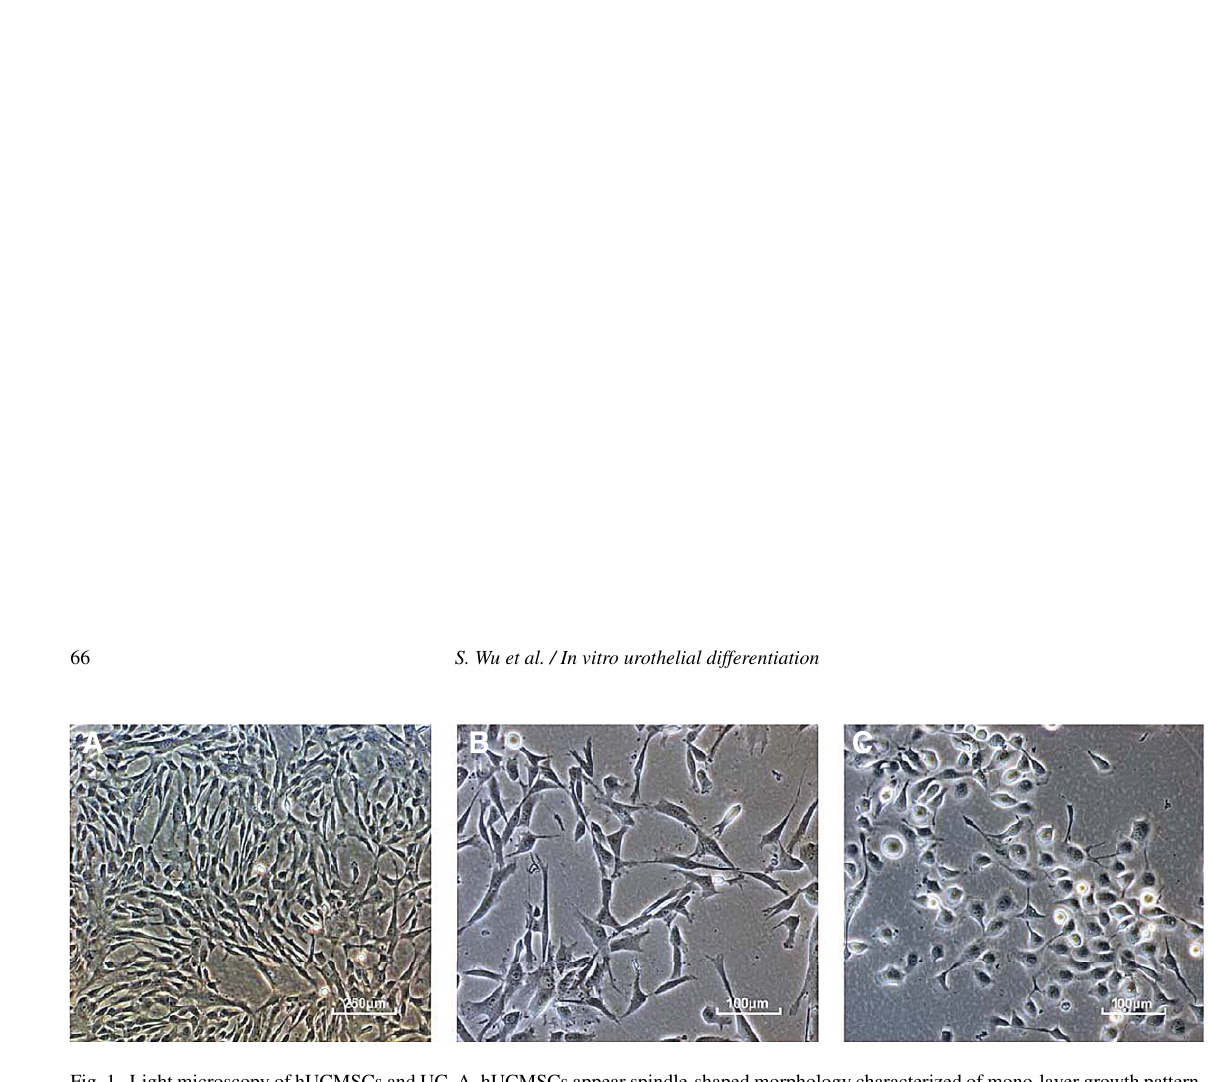
Fig. 1. Light microscopy of hUCMSCs and UC. A. hUCMSCs appear spindle-shaped morphology characterized of mono-layer growth pattern. B. Induced hUCMSCs exhibit polygonal epithelium-shape similar to UCs after 2 weeks induction with UC-CM supplemented with 20ng/ml EGF. C. UCs exhibit typical cobblestone morphology. hUCMSCs: human umbilical cord-derived mesenchymal stromal cells. UCs: urothelial cells. UC-CM: conditioned medium derived from urothelial cells. EGF: epidermal growth factor.